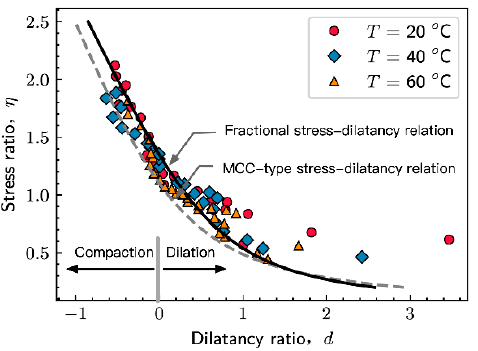
Figure 5. Stress–dilatancy relation on the Bourke clay at different temperatures (data from (Uchaipichat and Khalili [24])).